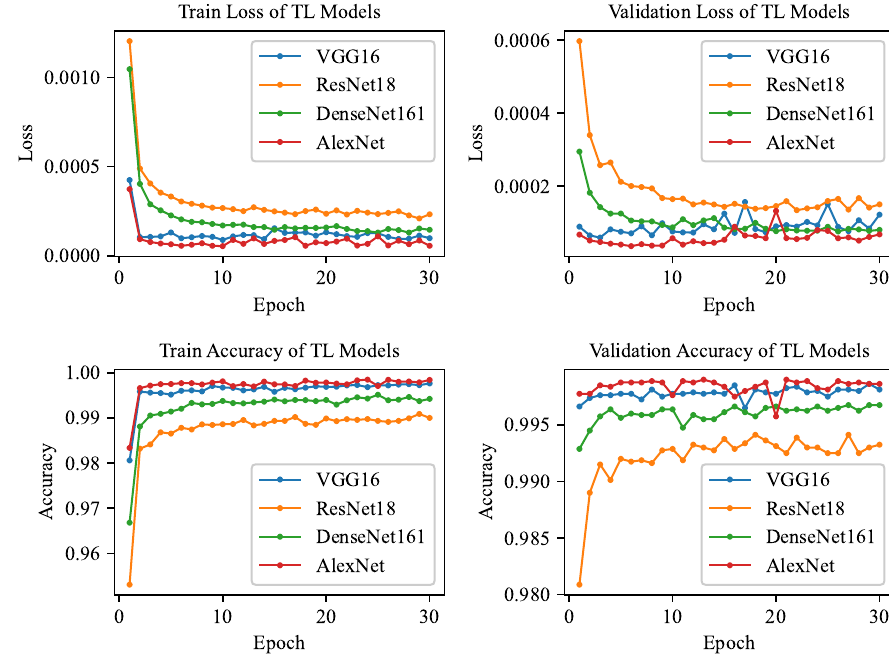
Figure 11. Loss and accuracy of all TL models both in Train and